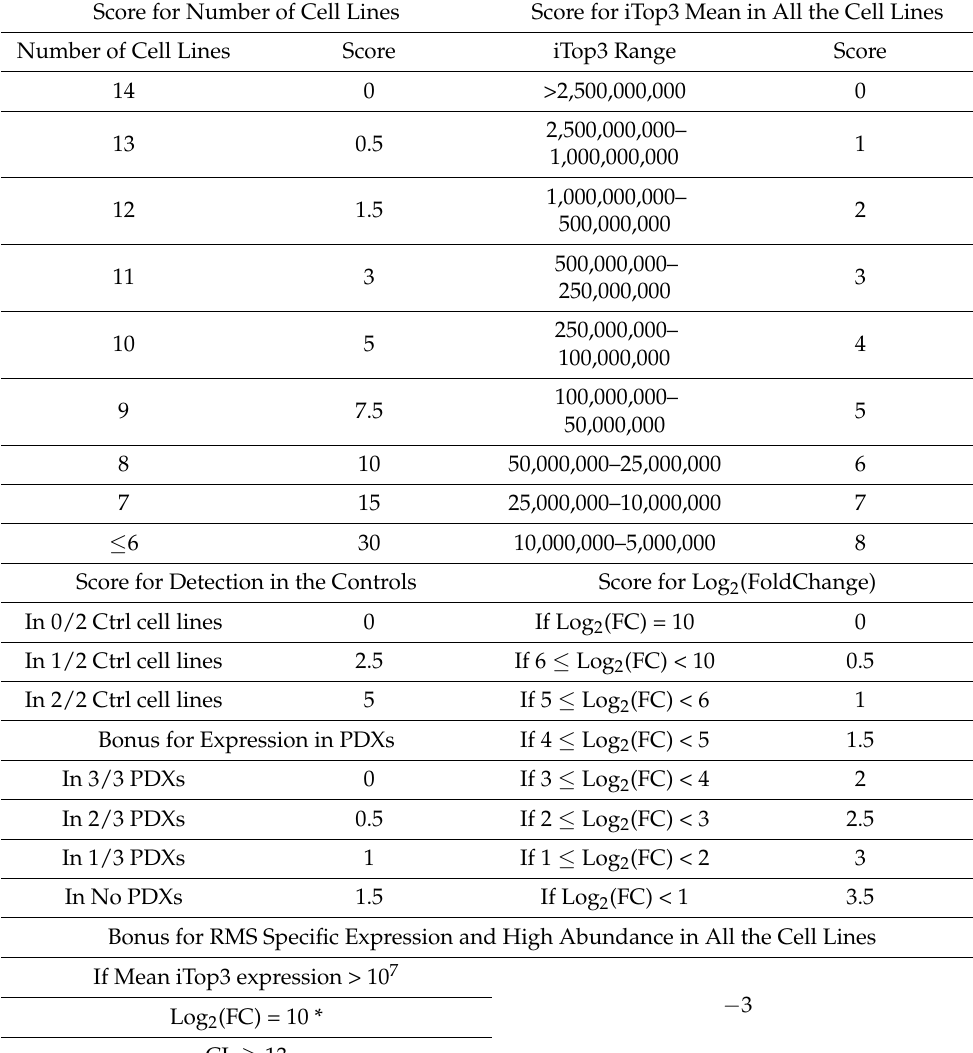
Table 1. Scoring for membrane/surface proteins extracted from the proteomics data analysis. Score for Number of Cell Lines Score for iTop3 Mean in All the Cell Lines Number of Cell Lines Score iTop3 Range Score 14 0 >2,500,000,000 0 0.5